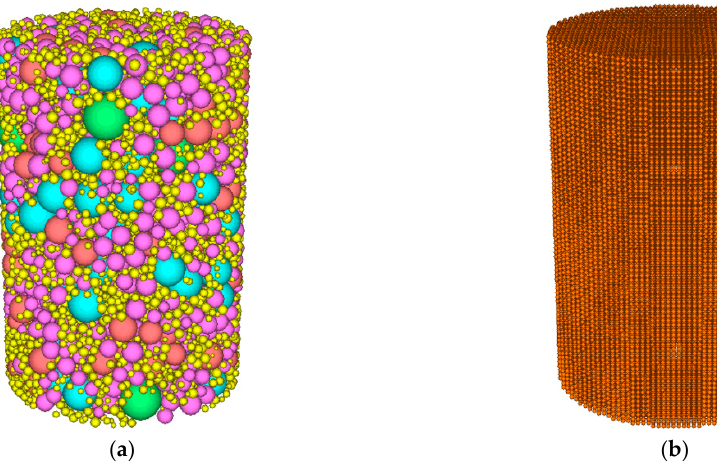
Figure 3. ( a ) Graded coarse aggregates; ( b ) uniform-sized packed discrete elements.